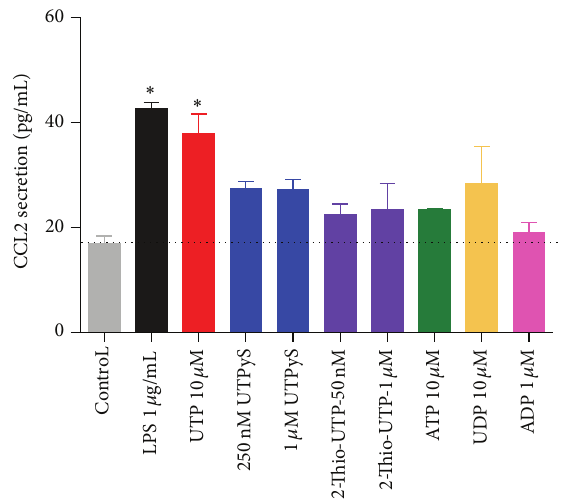
Figure 3: Nucleotides induce CCL2 secretion from THP-1 cells after 2-hourstimulation. THP-1cells were plated inRPMImedia contain- ing 1% serum and stimulated with media alone, LPS (1 𝜇 g/mL), UTP (10 𝜇 M), UTP 𝛾 S (250nM and 1 𝜇 M), 2-thio-UTP (50nM and 1 𝜇 M), ATP (10 𝜇 M), UDP (10 𝜇 M), or ADP (10 𝜇 M) for 2 hours. Mean raw data is plotted in pg/mL ± SEM. Standard curves were performed for each ELISA experiment with fits of 𝑟 > 0.95